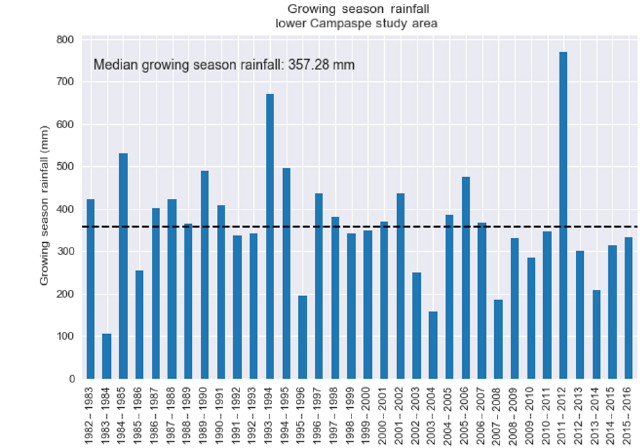
Figure 5. Long term growing season rainfall. Median in-season rainfall was found to be 420.45mm (dashed black